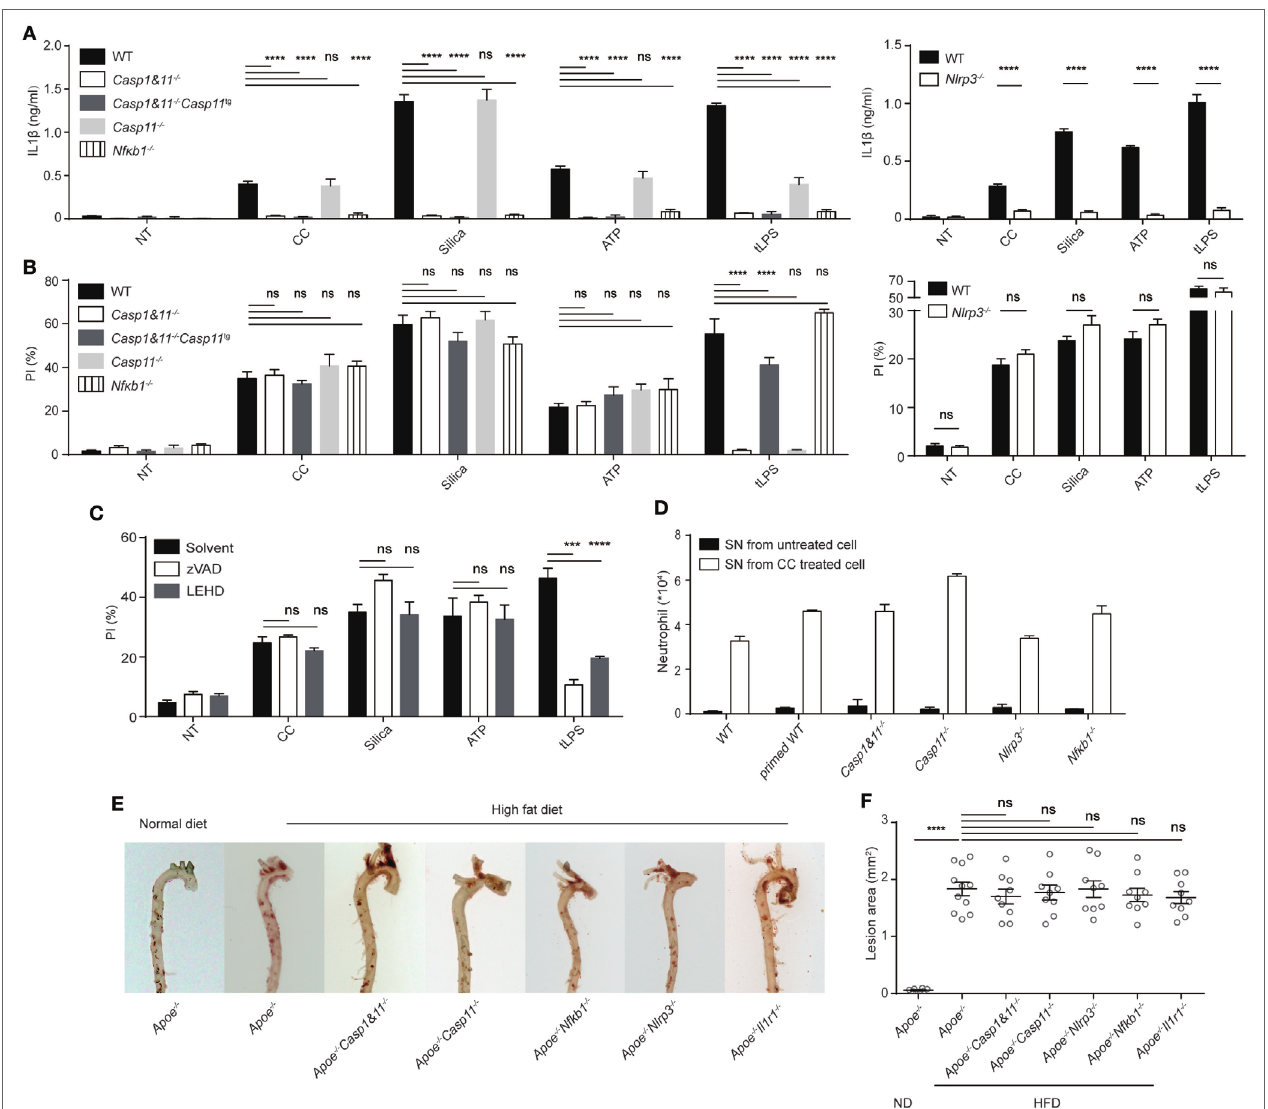
FigUre 2 | Cholesterol crystals (CC)-mediated cell death and its pro-inflammatory property is unrelated to NLRP3 inflammasome. (a) BMDM with indicated genotypes were primed with Pam3csk4 then treated with indicated stimuli for 6 h as in Figure 1c . IL-1 β was determined by ELISA. n = 4. N = 4. (B) BMDM were primed and then treated as in Figure 1c except treatment duration (CC: 2 h, Silica: 1 h, ATP: 2 h, tLPS: 6 h). Cell death was determined by PI staining. n = 6. N = 5. (c) BMDM were primed then pretreated with Caspase inhibitor (z-VAD-FMK: 10 µM, z-LEHD-FMK: 2 µM) 0.5 h before the stimulus treatments as in (B) . Cell death was determined as in (B) . n = 6. N = 5. (D) BMDM from WT or gene-deficient mice were cultured. Supernatants were collected and injected identical to Figure 1B . 16 h later, intraperitoneal cells were harvested and stained as in Figure 1B . n = 3. N = 3. (e) Inflammasome component-deficient mice were crossed to Apoe − / − . Homozygous mice were fed with high-fat diet for 12 weeks and then the aorta from these mice were stained with Oil Red O. (F) The aortas in E were opened en face (Figure S2 in Supplementary Material) and imaged with microscope. The area of red plaques was determined with Olympus microscope image program based on pixel